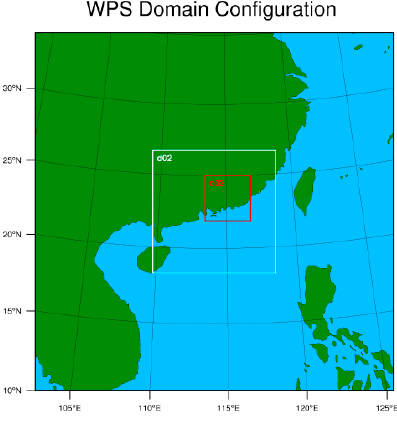
Figure 2. Division of WRF grid for “Nuri”.